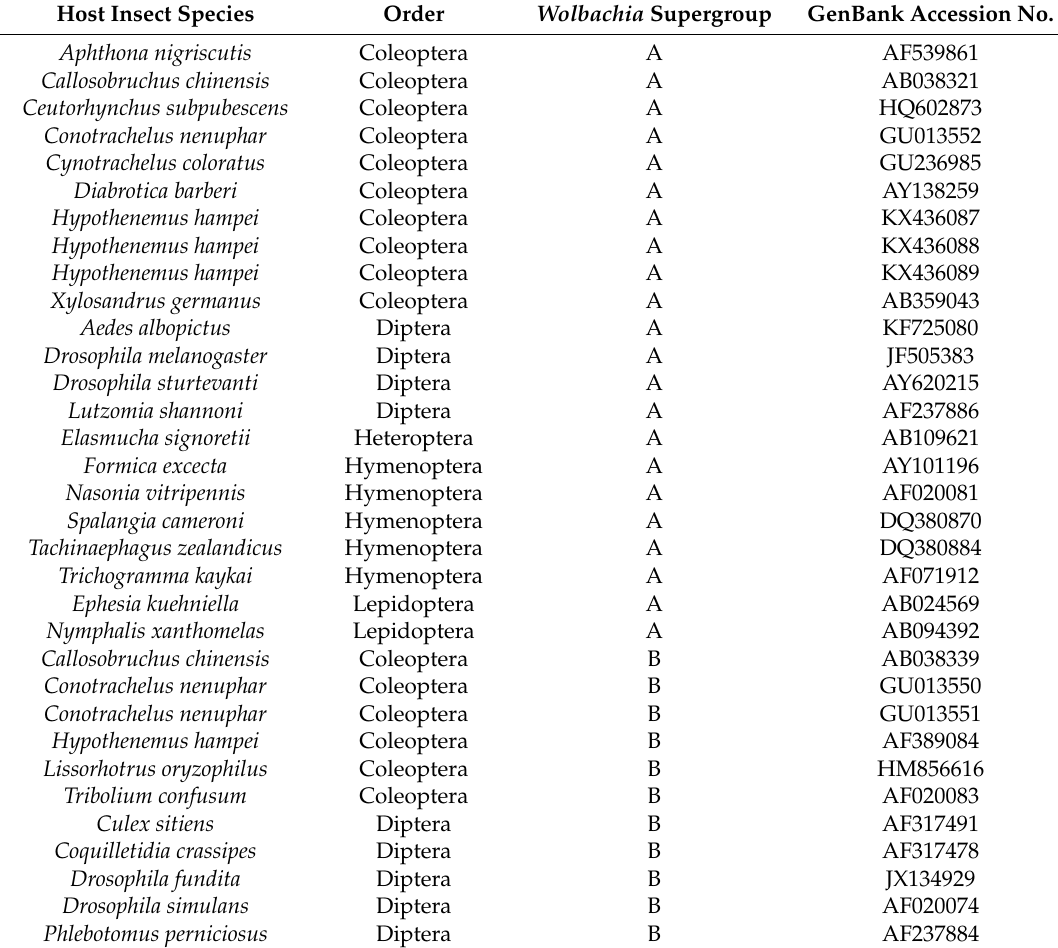
Table A1. Reference sequences of Wolbachia used to determine CBB Wolbachia supergroup